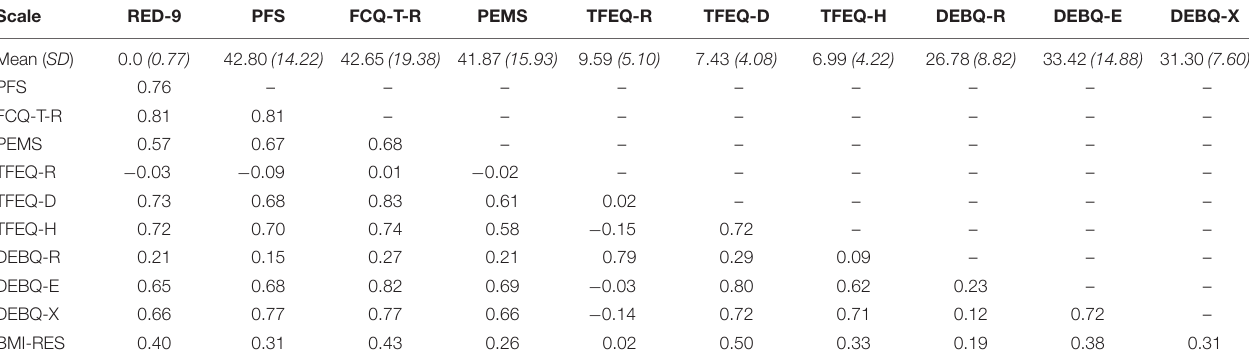
TABLE 3 | Correlations among the RED-9 and other scales in Study